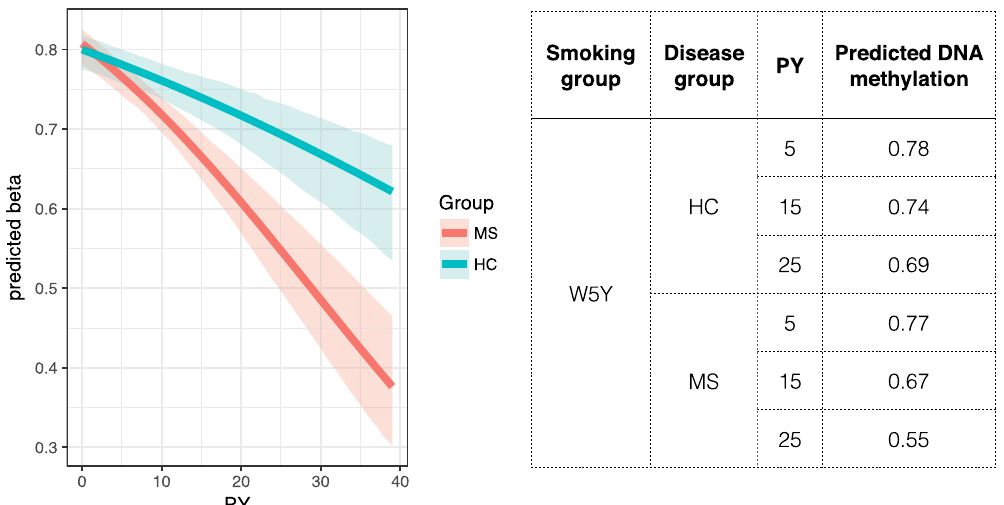
Figure 6. The effect of the pack-years interacts with the disease. The fitted β values were obtained as a function of Pack-Years (PY) for MS (red) and controls (blue) in the W5Y smoking category, by using a beta regression model, as indicated in the main text. 95% confidence levels were estimated by bootstrapping with 1000 replications and are shown as shaded